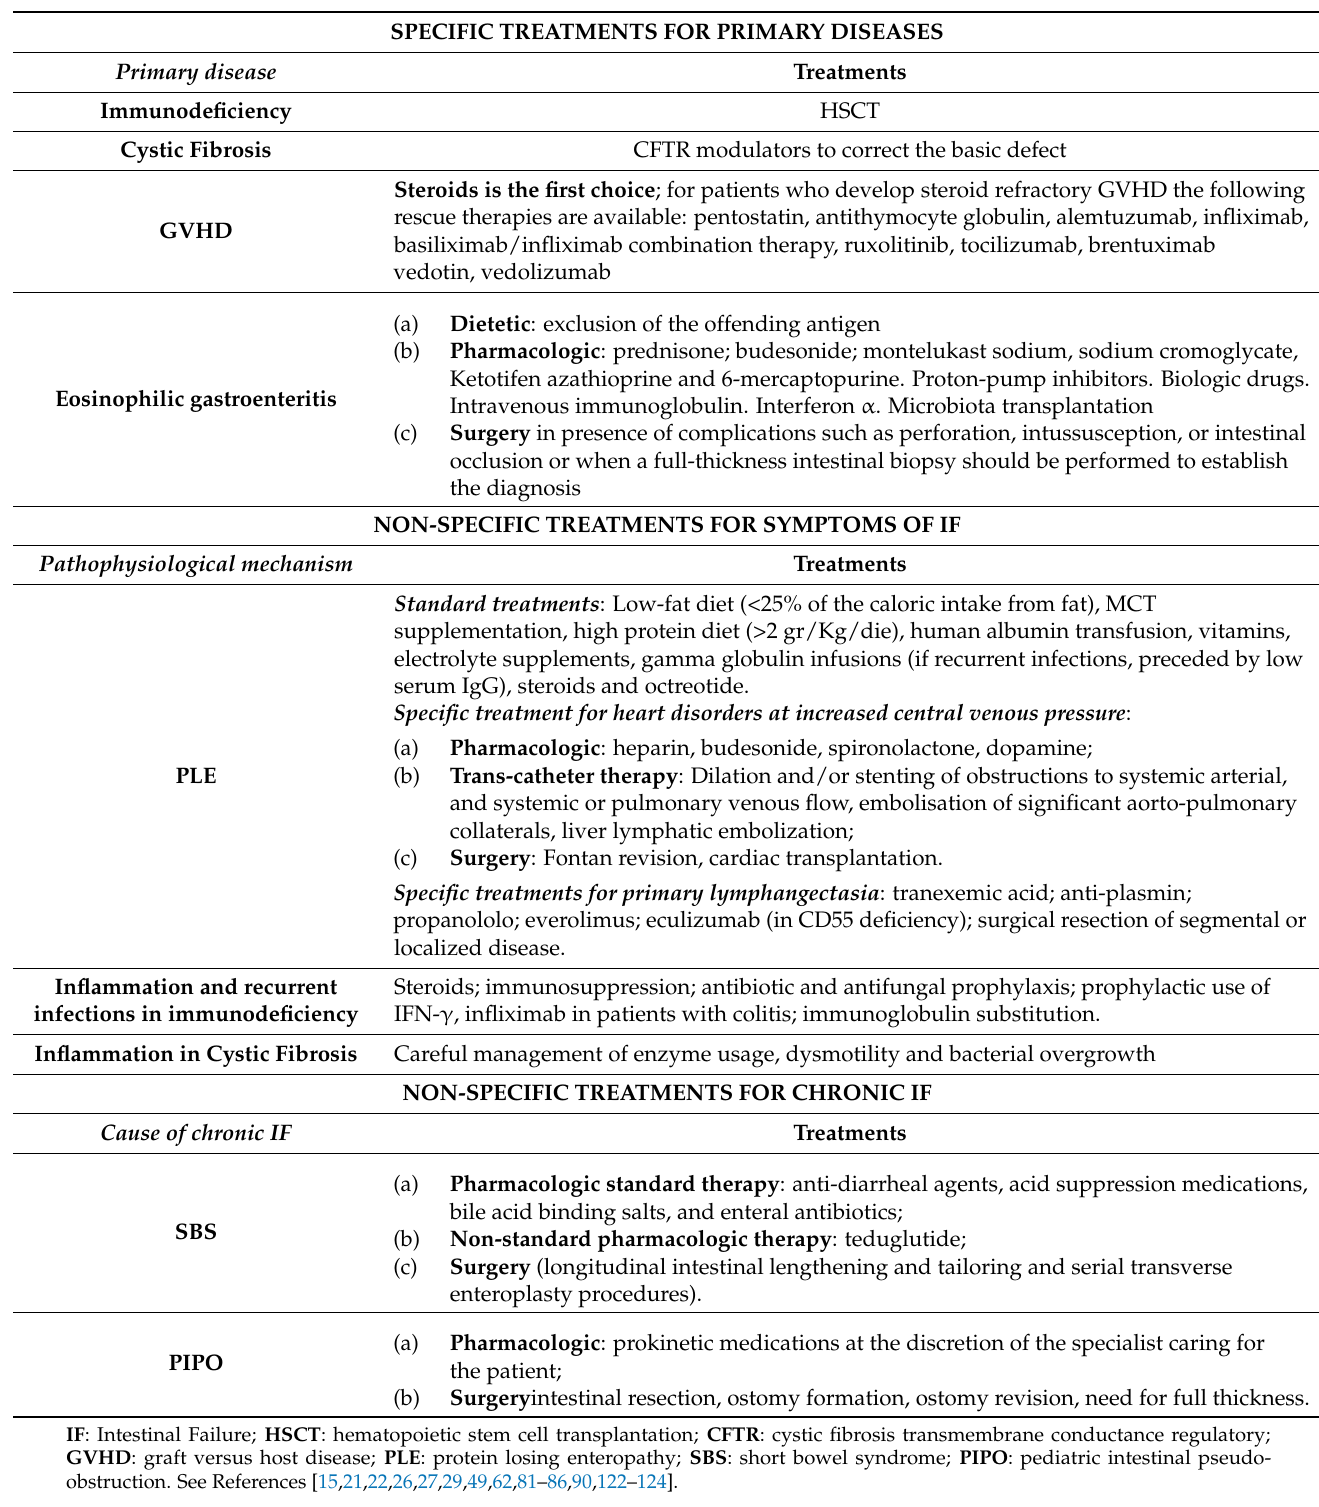
Table 4. Therapeutic approach in Intestinal